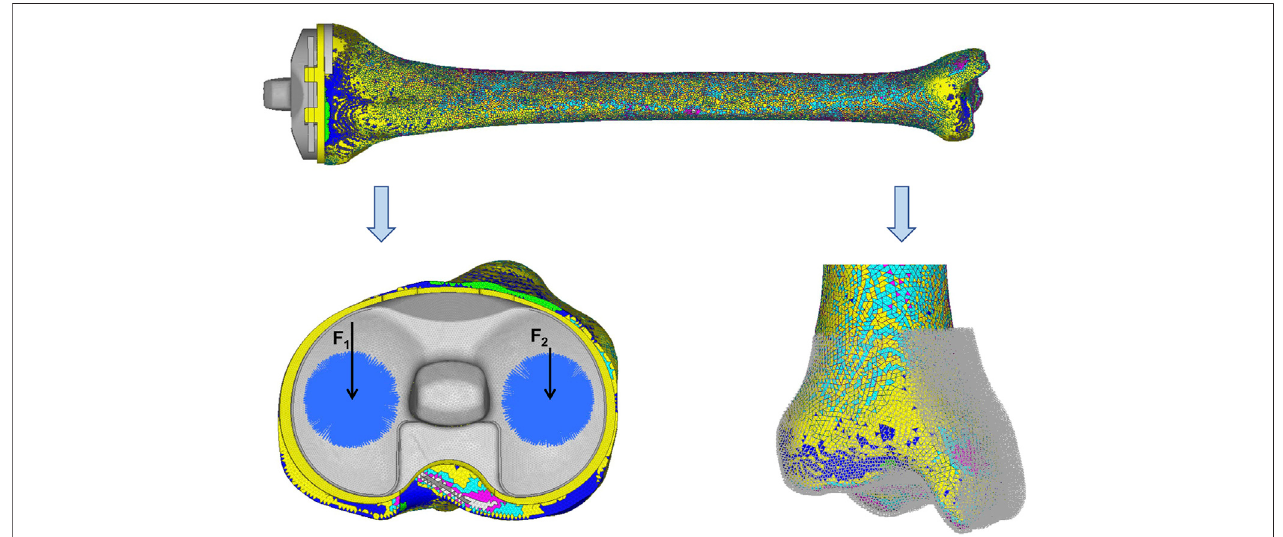
FIGURE 4 | Loads and constrains. F 1 (987 N) and F 2 (658 N) were set as the axial forces of the medial and lateral parts on the tibia insert, respectively. The distal tibia was constrained in all